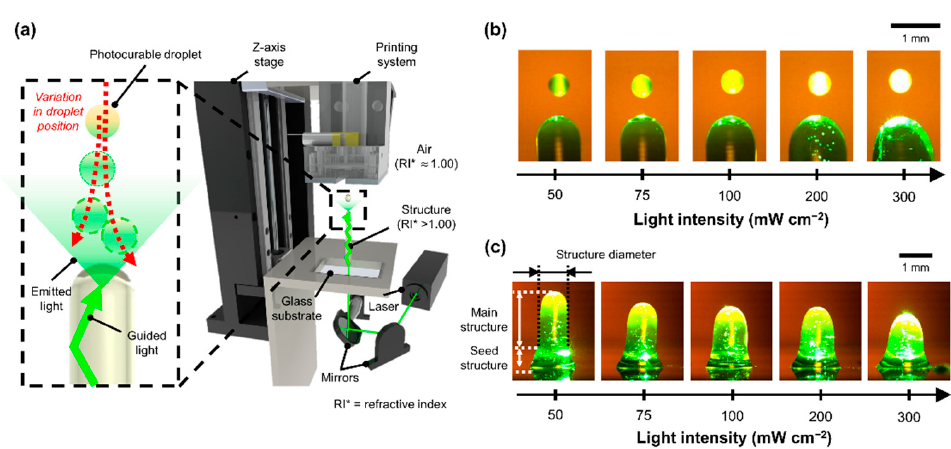
Figure 1. Light ‐ intensity ‐ dependent changes in dimensions of the structure. ( a ) Schematics of the investigated 3D printing system and the variation in droplet position; ( b ) effects of different light intensities irradiated onto the droplets, and ( c ) the light ‐ intensity ‐ dependent changes in structure dimensions. in structure